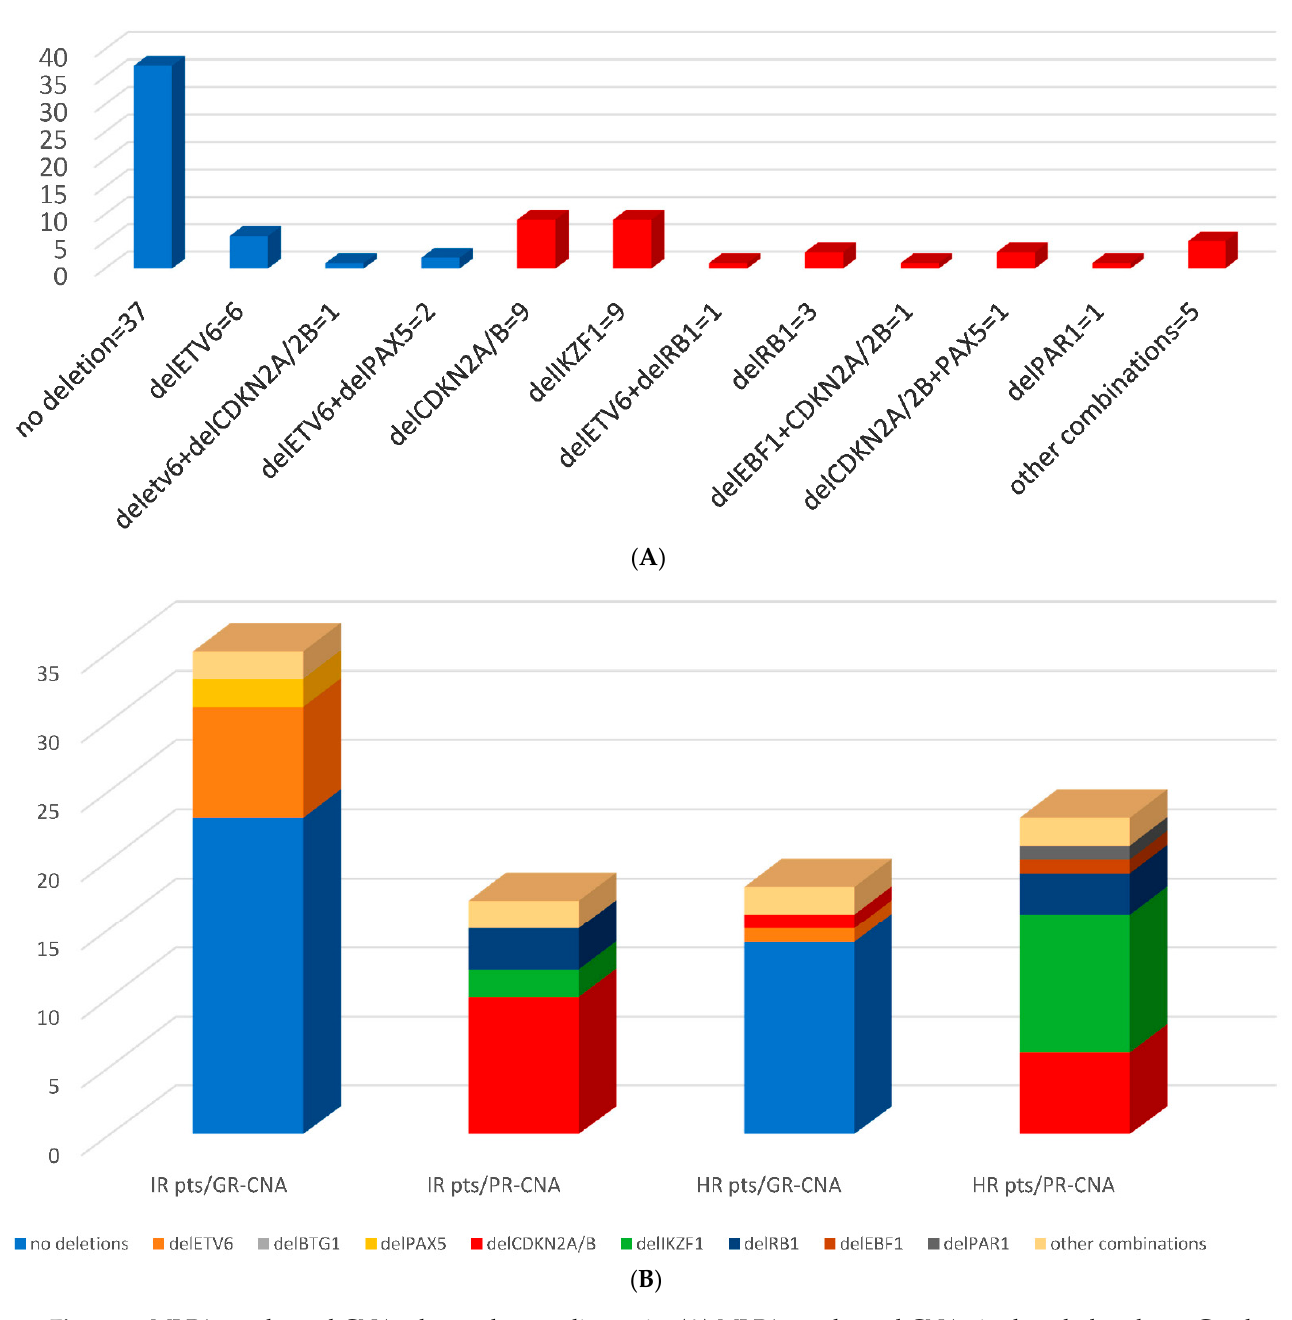
Figure 1. MLPA results and CNAs detected upon diagnosis. ( A ) MLPA results and CNAs in the whole cohort. Good risk (GR)-CNAs are displayed in blue color and poor risk (PR)-CNAs are shown in red. Other combinations include delCDKN2A/2B+delBTG1, delCDKN2A/2B+delRB1, delIKZF1+delCDKN2A/2B, delIKZF1+delCDKN2A/2B+delPAX5, delIKZF1+delETV6. Del = dele